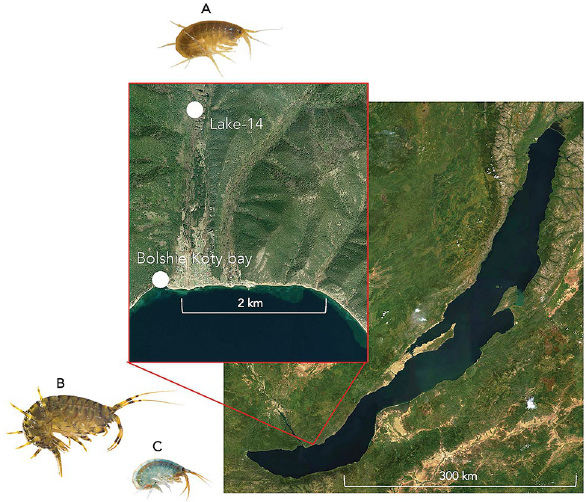
Figure 1. Sampling sites at Lake Baikal. Gammarus lacustris Sars,1863 ( A ) was sampled in a small shallow artificial water body named Lake-14 (51° 55 ′ 14.39 ′′ N, 105° 4 ′ 19.48 ′′ E). The Baikal species Eulimnogammarus verrucosus (Gerstfeldt, 1858) ( B ) and Eulimnogammarus cyaneus (Dybowski, 1874) ( C ) were sampled at the shoreline of Lake Baikal, close to Bolshie Koty (51° 54 ′ 11.67 ′′ N, 105° 4 ′ 7.61 ′′ E). The aerial maps